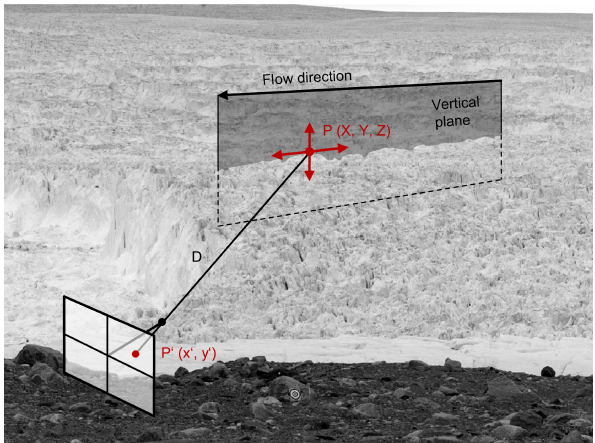
Figure 14. Transformation into object